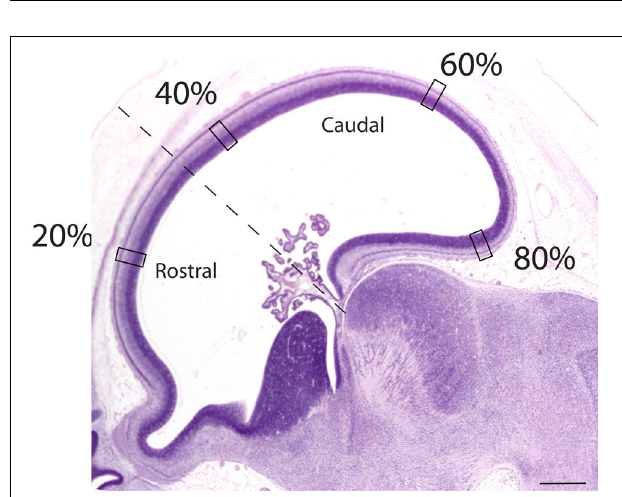
FIGURE 3 | Representation of a sagittal section used to estimate the progenitor cells along the rostro-caudal axis of the cerebral cortex. The ventricular length was estimated and divided into percentiles. Estimates of the progenitor cell numbers at every 20, 40, 60, 80% along the ventricular surface were made. Represented here is a sagittal section of an embryonic day 34 dog (CRL 32mm). The dashed lines mark the boundary between the rostral and caudal cortex. Scale bar is